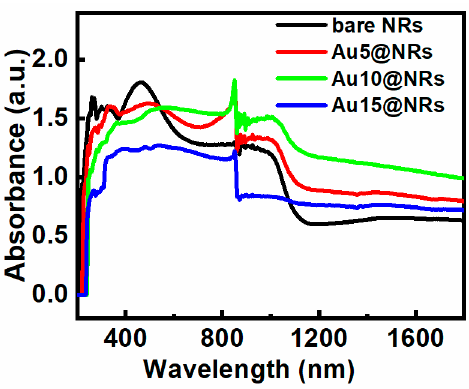
Figure 3. Absorption spectra of bare NRs, Au5@NRs, Au10@NRs, and Au15@NRs.